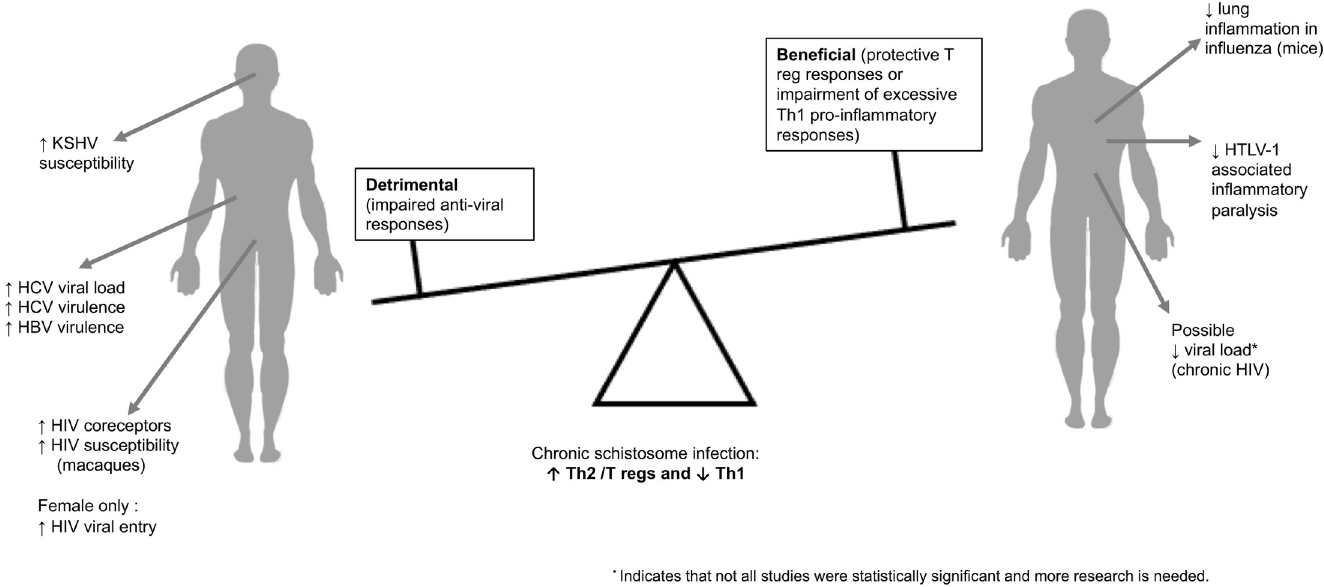
Fig 2. Chronic schistosome infection was associated with impaired anti-viral responses in some viral infections. In others, chronic schistosome infection appeared to offer protection against viral infection attributable to T regulatory responses or to control of excessive Th1 inflammatory responses.